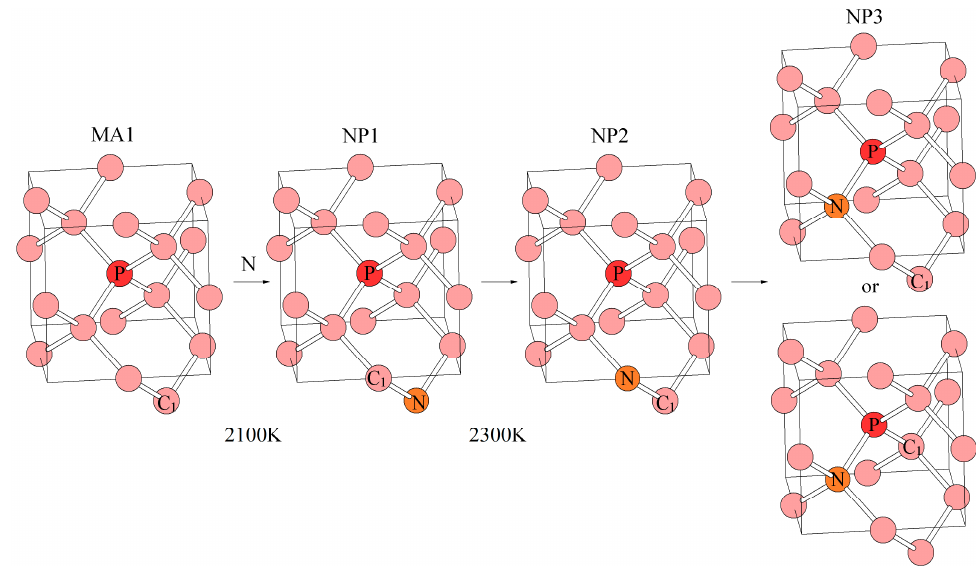
Figure 4. Supposed structures of MA1, NP1 (NIRIM8), NP2, and NP3 centers in synthetic microdiamonds grown in the C–P system.